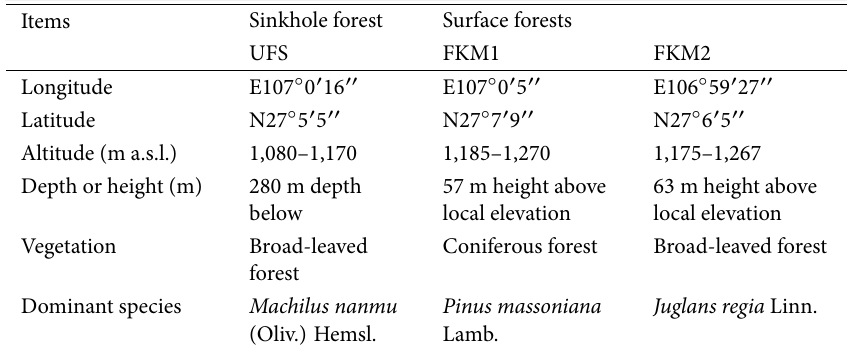
Table 1 Details of the forest survey